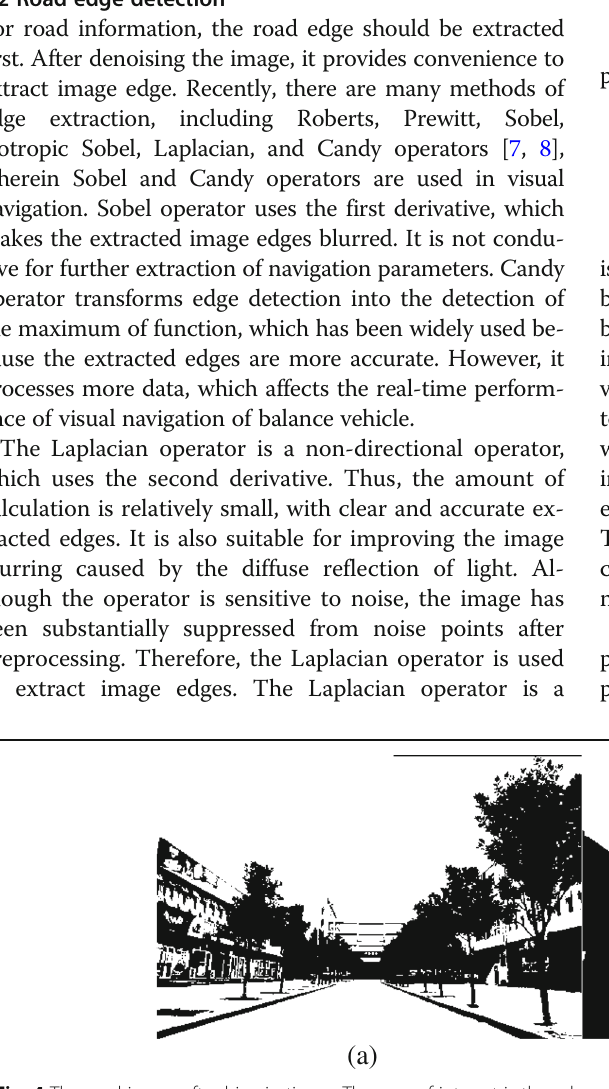
Fig. 4 The road image after binarization. a The area of interest is the edge of the road. b The area of interest is the central line of the